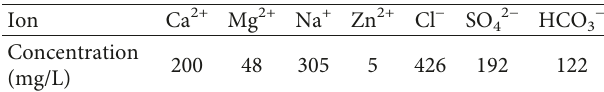
Table 1: The composition and content of the standard water used in the